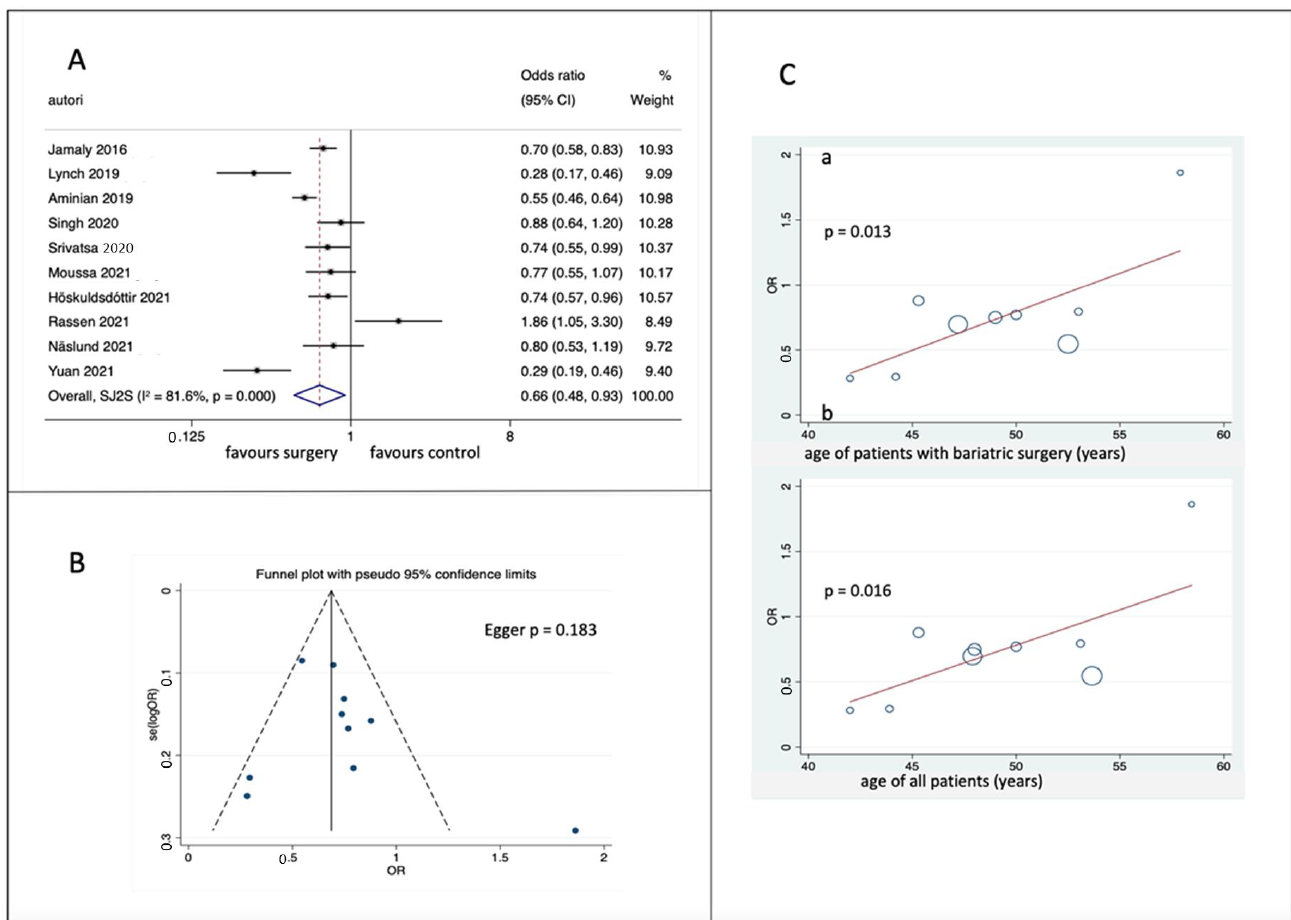
Figure 2. ( A ) Forest plot of pooled hazard ratios of atrial fibrillation [22,25–33]; ( B ) funnel plots with 95% CI; ( C ) meta-regression analysis of effect as a function of age of BS patients (a) and of the whole cohorts (b). OR = Odds Ratio; 95% CI = confidence interval; SE, standard error. In a second sensitivity analysis, the effect of the percentage of weight loss was con- sidered; the effect was significant for a weight loss ≥ 22%, [OR = 0.525 (0.316 – 0.872), 0.013], with lower but still significant heterogeneity (Q = 25.52, p < 0.001, I 2 = 84.2%); the effect was non-significant for a weight loss < 22%, [OR = 0.827 (0.539 – 1.271), p = 0.387] with lower but still significant heterogeneity (Q = 22.30, p < 0.001, I 2 = 82.1%). Then, the role of the percentage of patients with diabetes was considered; for a percentage < 100% (7 studies), the effect was significant [OR = 0.596 (0.406 – 0.875), p = 0.008], with significant heterogene- ity (Q = 30.19, p < 0.001, I 2 = 80.1%); for a percentage = 100% (3 studies), the effect was non- significant [OR = 0.880 (0.394 – 1.969), p = 0.756, NS)], but still with significant heterogeneity (Q = 18.43, p < 0.001, I 2 89.1%). Finally, the effect was evaluated according to the Newcastle- Ottawa Quality Assessment Scale (NOS); the effect was statistically significant [OR = 0.570 (0.365 – 0.890), p = 0.013] for higher NOS score (above mean NOS), and heterogeneity was significant (Q = 29.64 p < 0.001, I 2 = 83.1%); the effect was non-significant for NOS score below mean NOS [OR = 0.840 (0.477 – 1.478), p = 0.545], and heterogeneity was still signifi- cant (Q = 19.27 p < 0.001, I 2 = 84.43%). Since one study [32] showed a different age from other studies and contributed to I 2 heterogeneity for more than 13% [39,40], a sensitivity analysis was performed by excluding this study (Supplementary Figure S1); OR was sim- ilar [OR = 0.62 (95% CI 0.51 – 0.76, p < 0.001)]; heterogeneity was reduced but was still sig- nificant (Q = 35.70, p < 0.001; I 2 = 77.6%), and again the meta-funnel showed no publication bias. At meta-regression BMI correlated with the effect ( p = 0.052 when considering BMI of patients undergoing BS, p = 0.054 when considering BMI of the whole cohort); more,